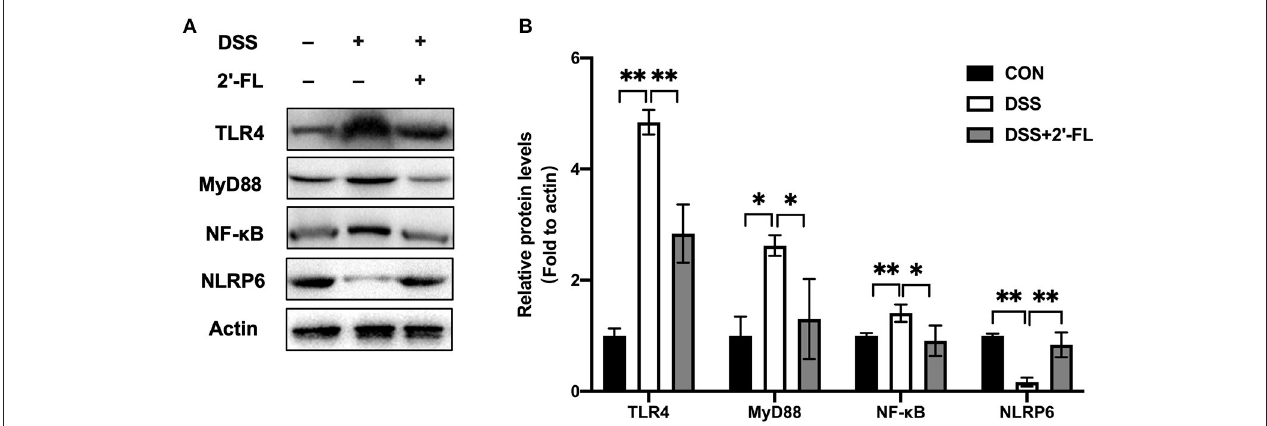
FIGURE 9 | Protein expression of factors in TLR4-related pathway in mouse colon tissue. (A) Immunoblot bands of Actin, TLR4, MyD88, NF- κ B and NLRP6 in colon tissue. Actin was regarded as an internal reference. (B) Densitometric quantitation for normalized proteins relative to Actin (%) in colon tissue, analyzed by Image J software. * p < 0.05; ** p < 0.01.